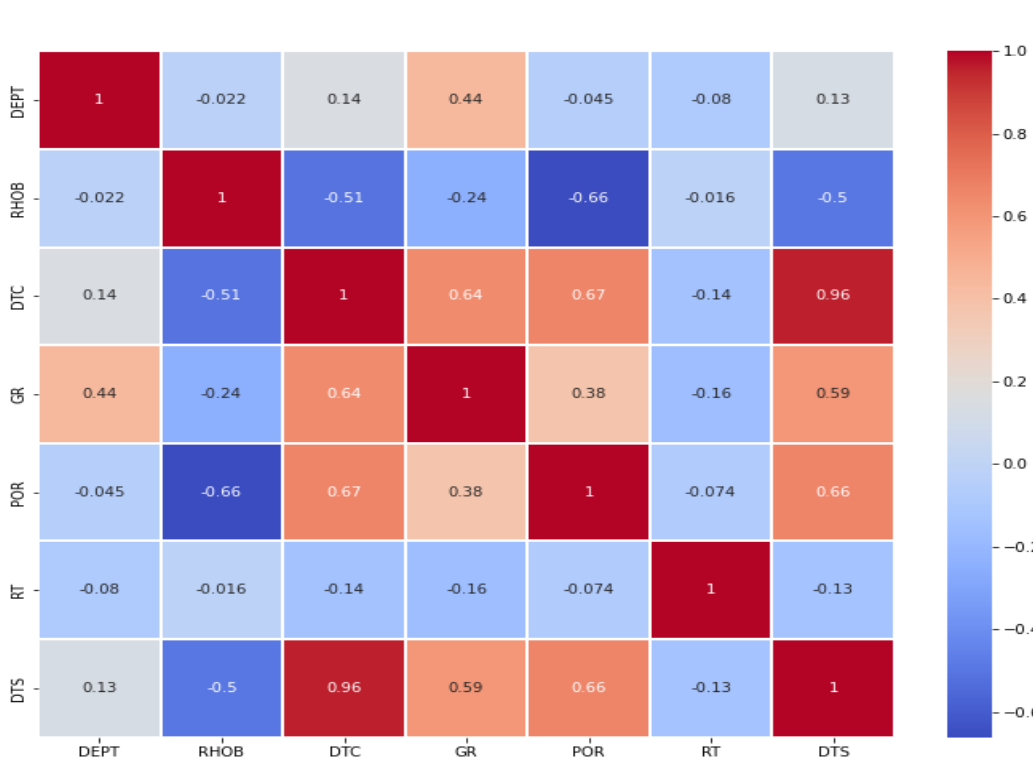
Figure 8. Heat map for cross well.